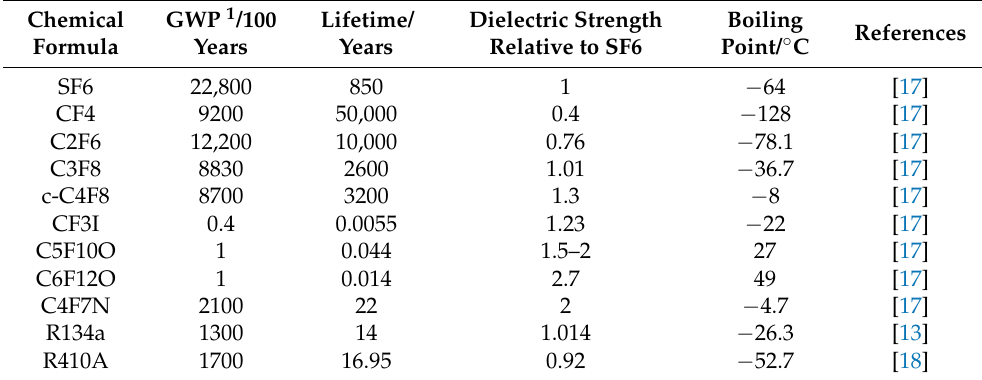
Table 1. Properties of alternatives to